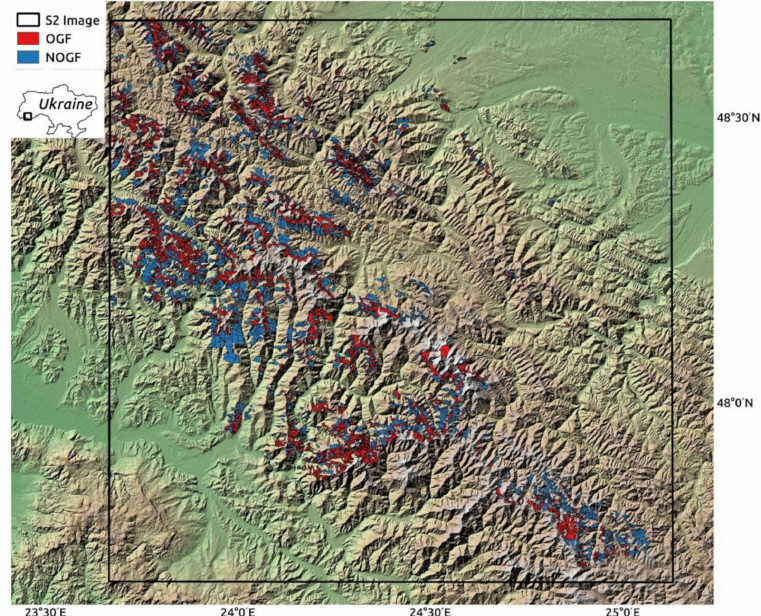
Figure 1. Relief map (elevation range 200–2060 m) of the study site showing Old-Growth Forest (OGF, shown as red polygons) and Non-Old Growth Forest (NOGF, shown as blue polygons). S2 image shows the extent of the Sentinel-2 image used in the study. Inset map shows the location of the study area within